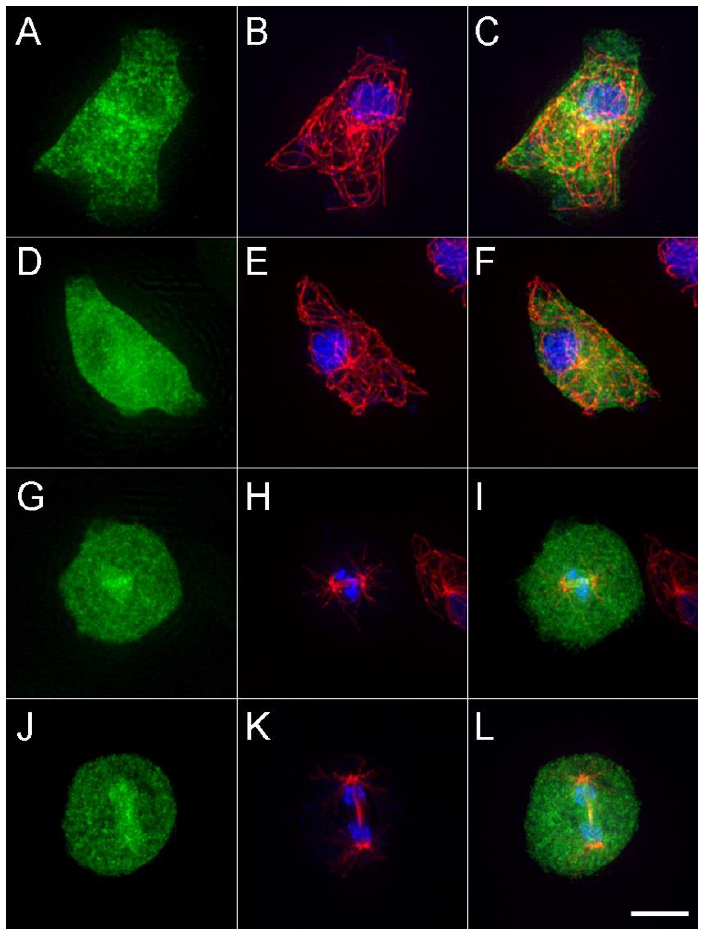
Figure 3. The cellular distribution of DdKif10 725 . The left column (green) shows the maximum intensity projections of the DdKif10 distribution in two interphase ( A , D ) and two mitotic cells ( G , J ). Antibody-labelled MTs (red) and Hoechst-stained nuclei (blue) are shown in the middle column (panels B , E , H , K ), and the two frames are merged in the right column (panels C , F , I , L ). Scale bar = 5 µ